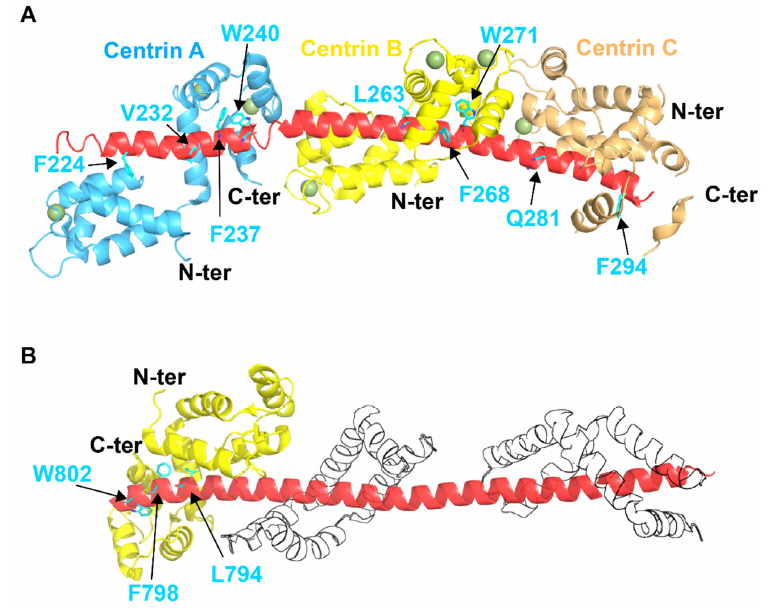
Figure 3. Crystal structures of ( A ) the complex between SFI1 and CDC31 molecules and ( B ) the complex between SAC3, SUS1, and CDC31. ( A ) Crystal structure of three yeast centrins CDC31 (light blue, yellow and orange) bound to SFI1 (PDB: 2DOQ). Ca 2+ ions are indicated by smudge green spheres. The anchoring residues for the interaction of SFI1 with CDC31 are indicated in cyan. ( B ) 3D structure of the complex CDC31 (yellow), SAC3 (red) and SUS1 (transparent) (PDB: 3FWC). The key residues constituting the large hydrophobic surface for the interaction of SAC3 with CDC31 are indicated in cyan.